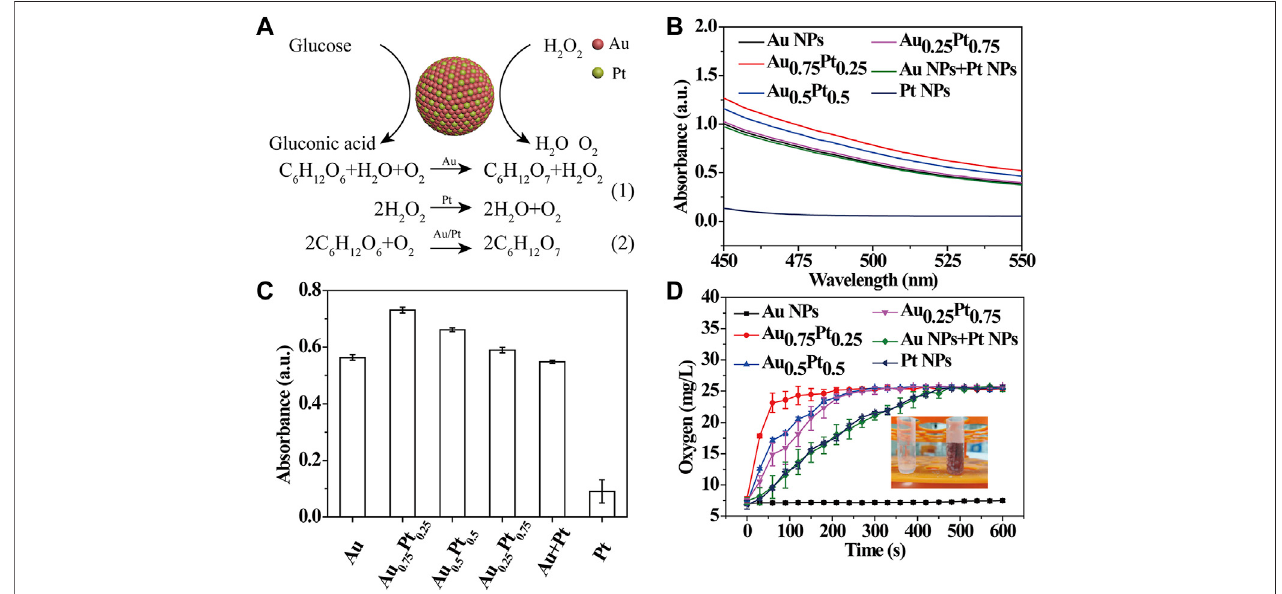
FIGURE 2 | Catalytic activity test of AuPt alloys. (A) Schematic illustration of catalytic oxidation of glucose in AuPt Alloys. (B) UV-vis absorption spectra of AuPt alloys with different proportions incubation with glucose for 4 h. AuPt alloys catalyzed the oxidation of glucose to gluconic acid, which is mixed with hydroxylamine and Fe 3+ toproducearedcomplex. (C) Absorbance valueat 505 nm determined byacolorimetricassay. (D) DissolvedoxygenlevelofAuPtalloyswithdifferentproportions solution after incubation with H 2 O 2